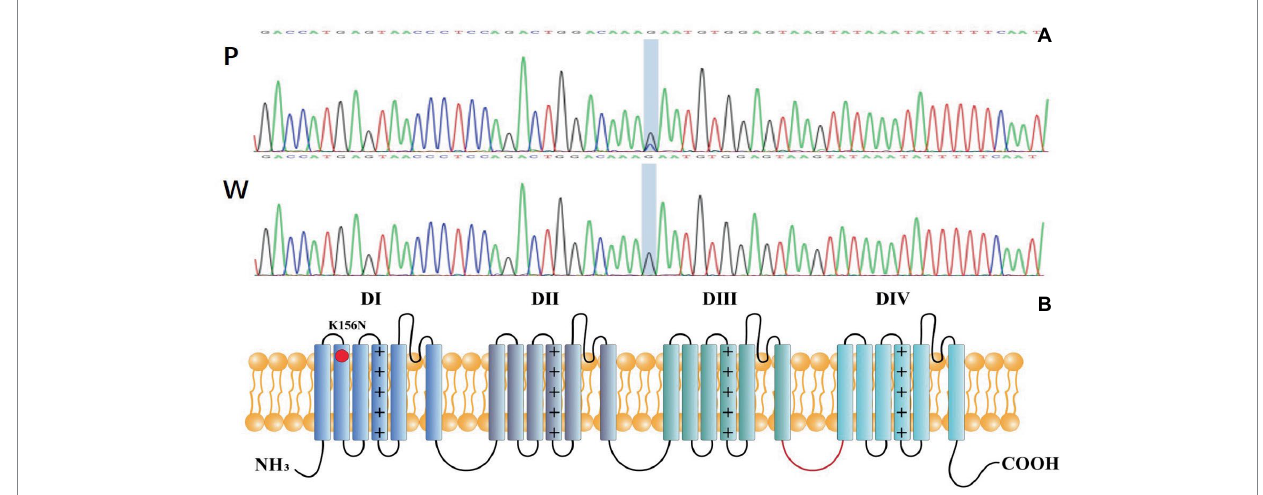
FIGURE 2 (A) P: Mutation genotype of the patient c.468G > C (p.K156N) ， W: wildtype genotype of the patient’s parents. (B) Topology diagram of the human Na v 1.2 channel’s α subunit. The location of the K156N variant described in the study is shown by a red